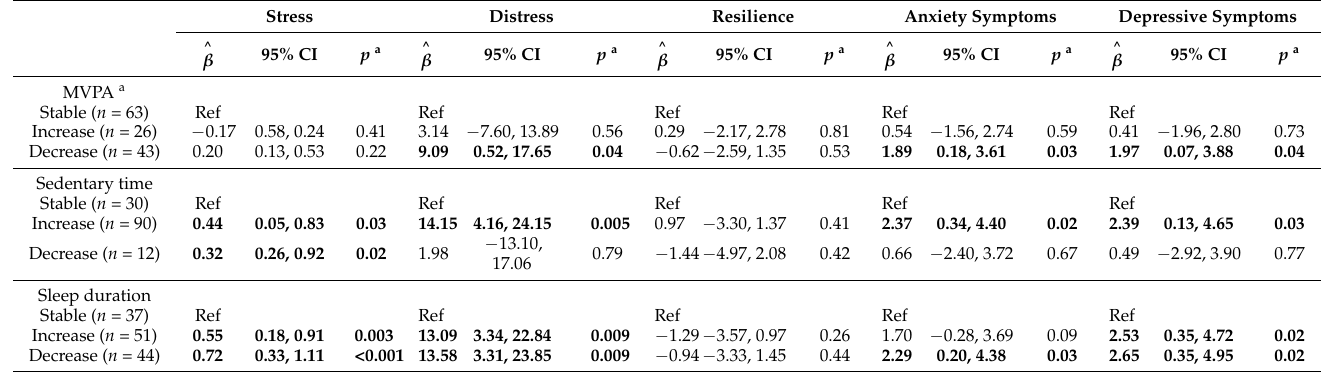
Table 3. Associations between changes in lifestyle behaviors on mental health indicators ( n =